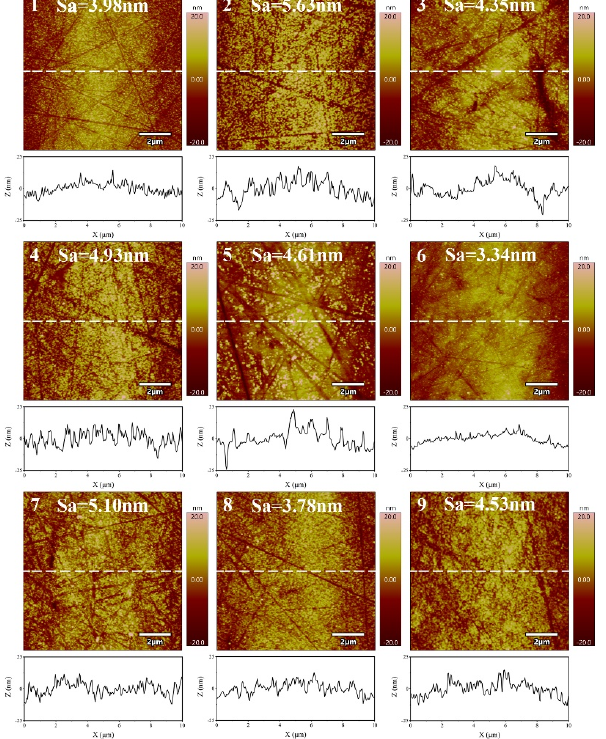
Figure 4. AFM images of amorphous alloy surfaces after the polishing experiment.